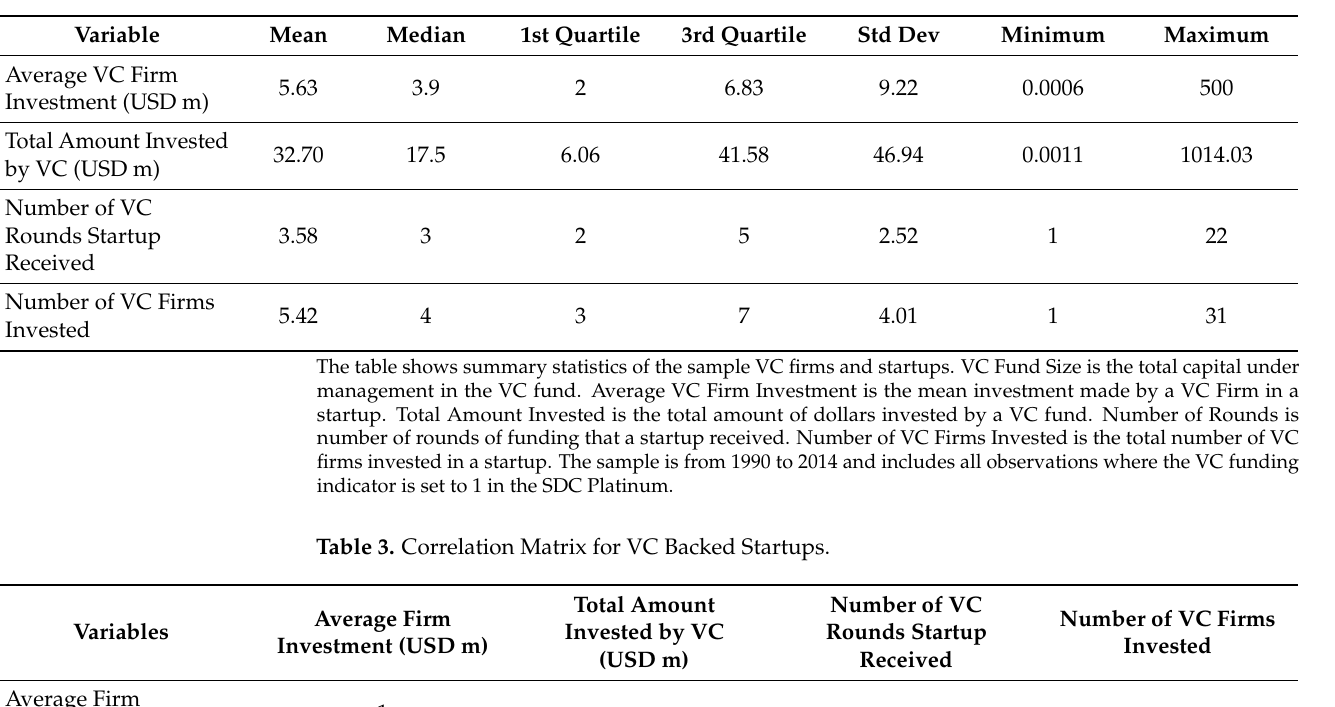
Table 2. Summary Statistics of VC Backed Startups.